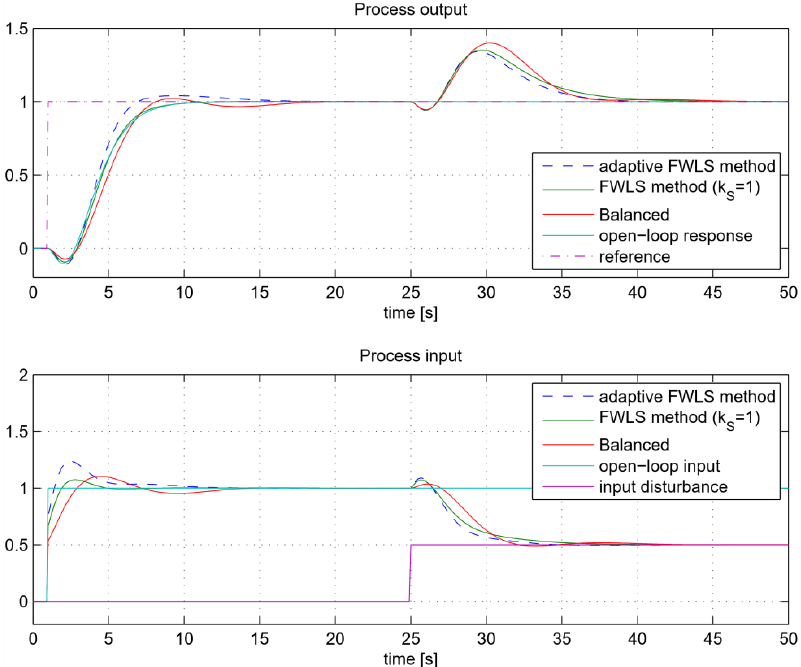
Figure 28. The closed-loop tracking and control signals for process G P 8 when using FLWS, adaptive FLWS and Balanced method.